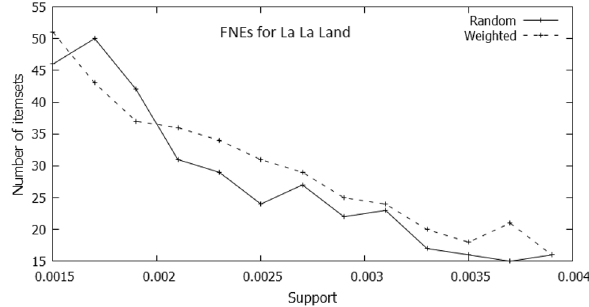
Fig. 6 Average number of itemsets for La La Land dataset